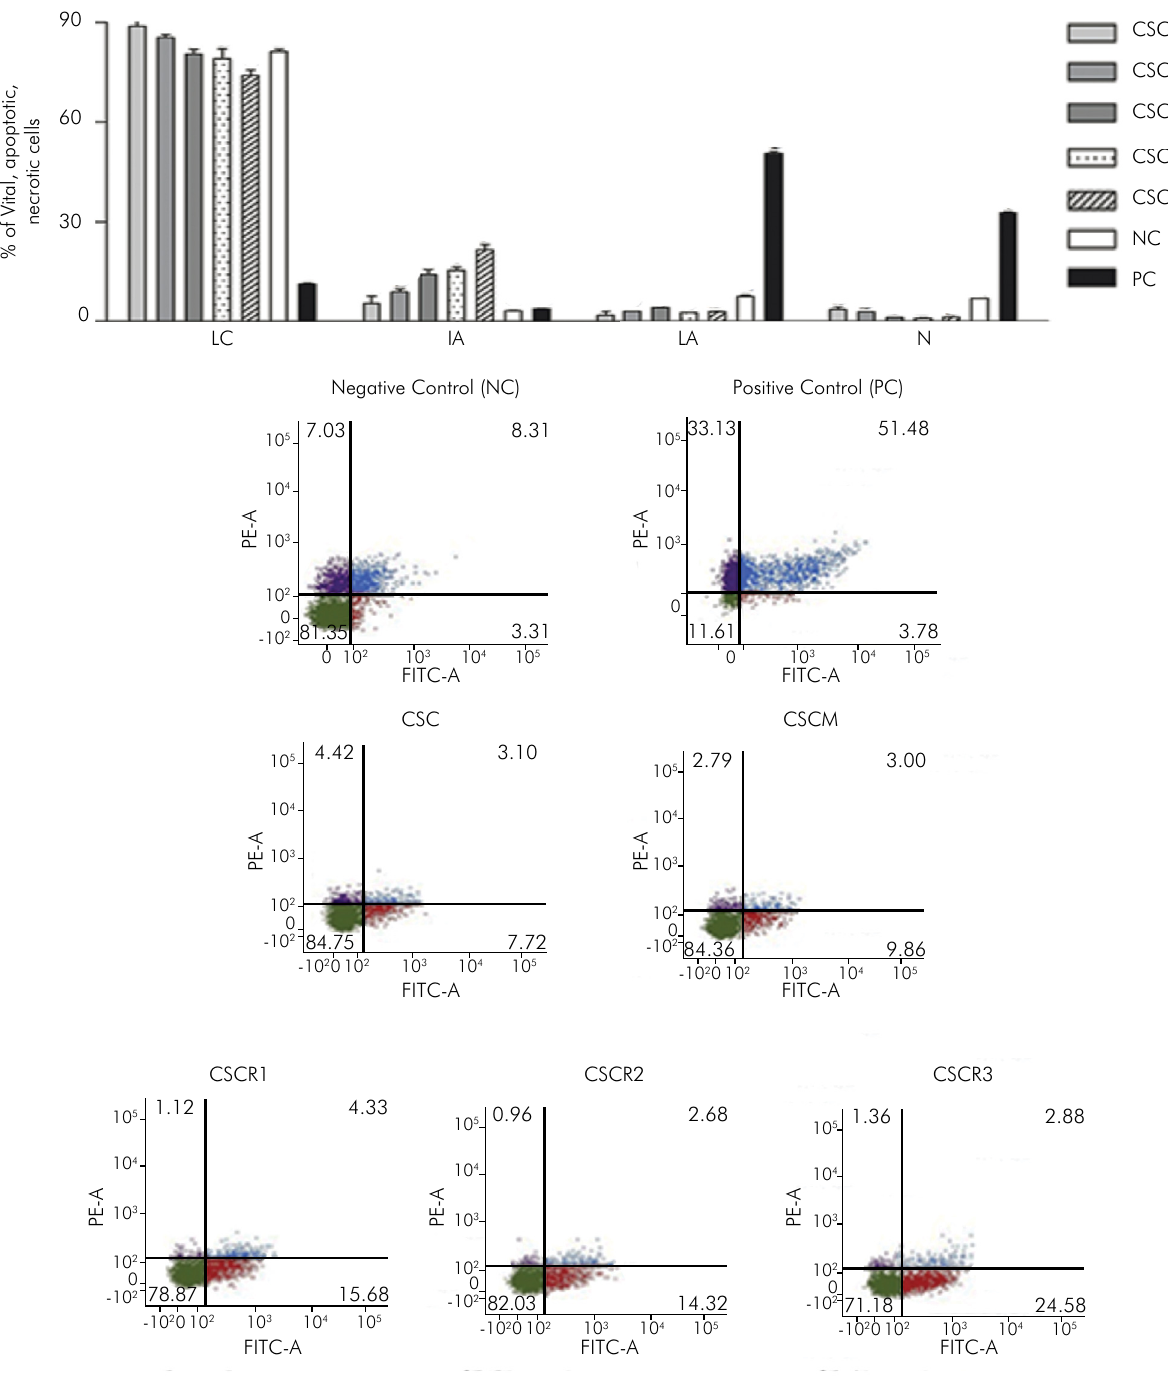
Figure 3. (A) Flow cytometry analysis of SAOS-2 viability, mortality by apoptosis or necrosis after exposure to different calcium silicate-based cements on the concentration of 10mg/mL after 24 hours. Cells exposed to medium were the negative control and cells treated with hydrogen peroxide (1 mM) were the positive control group. (B) Representative 2-dimensional flow cytometry dot plot of data derived from FITC-AnV and PE incorporated PI stained SAOS-2 cells of control, CSC, CSCM, CSCR1, CSCR2 and CSCR3 groups. Bars with different letters represent significant differences between groups in each population analyzed. The population of living cells (LC) (annexin-/ PI-), initial apoptosis (IA) (annexin+/ PI-), late apoptosisor secondary necrosis (LA) (annexin+/ PI+), and necrotic (N) (annexin-/ PI+)cells are represented in the left inferior, right inferior, right superior and left superior quadrants, respectively. PC = positive control, NC = negative